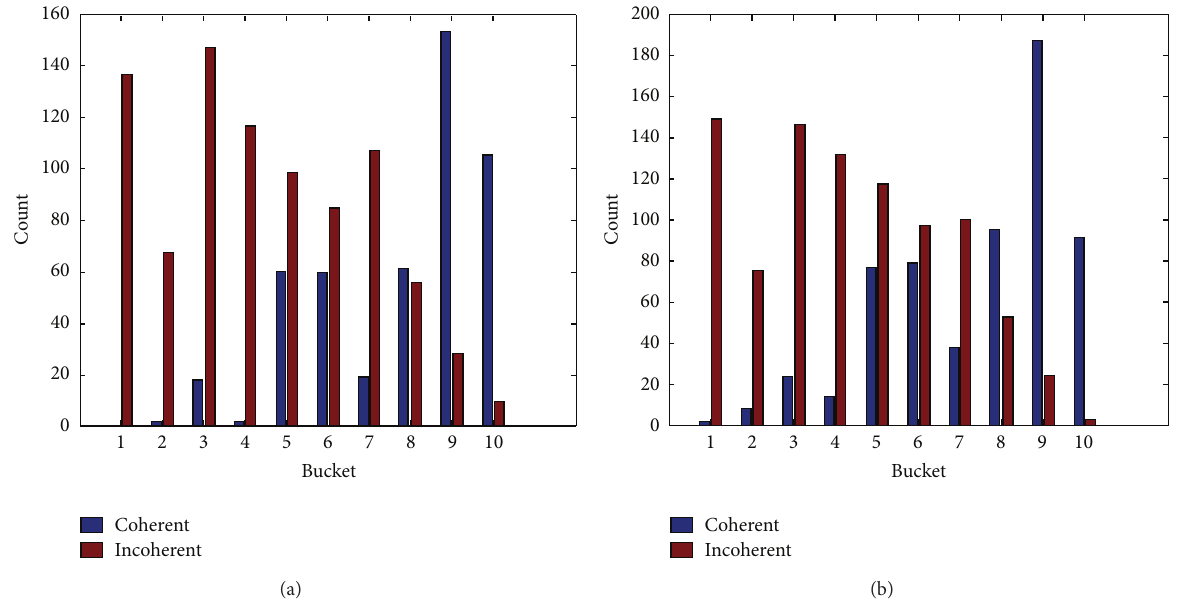
Figure 7: The MDCV histogram of two images. (a) The MDCV histogram of original Hippocampus image; (b) the MDCV histogram of Hippocampus image polluted by